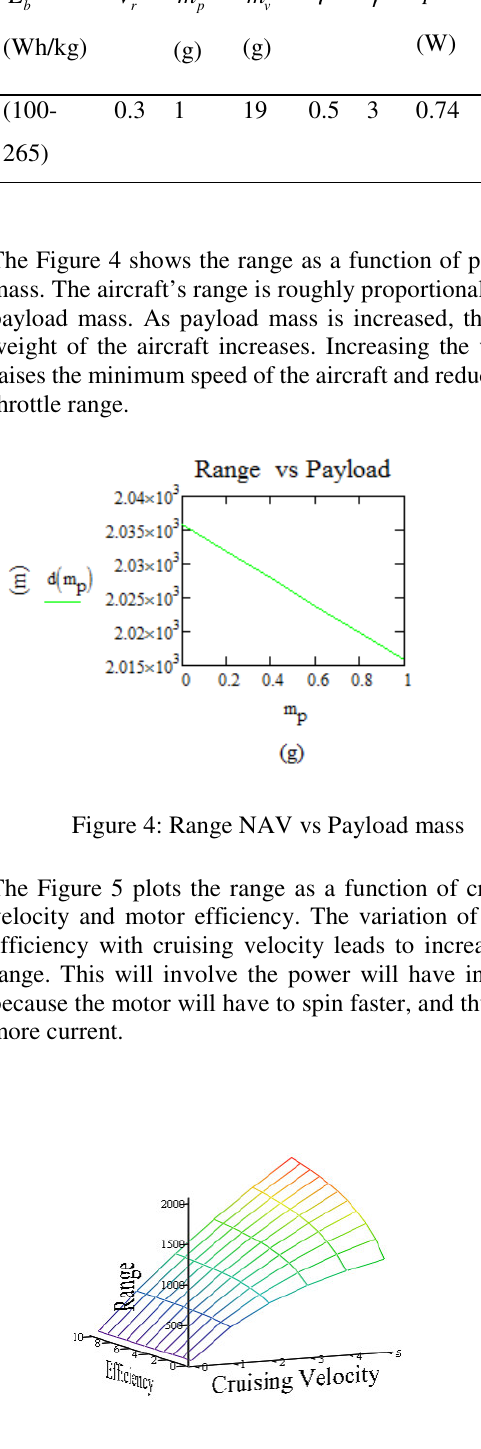
Figure 5: Range of NAV as a function of motor efficiency and cruising